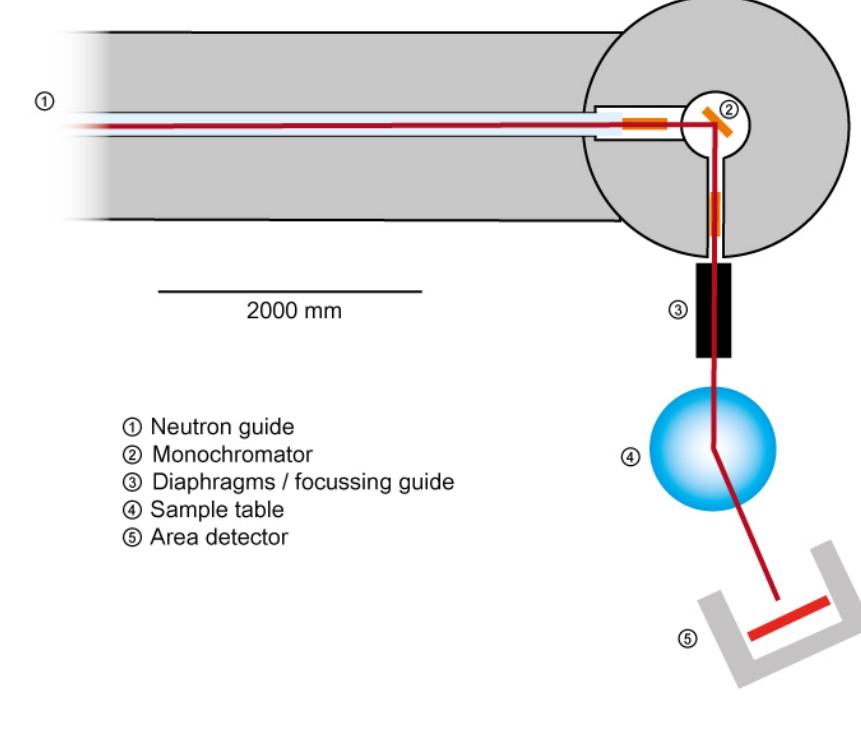
Figure 2: Schematic drawing of